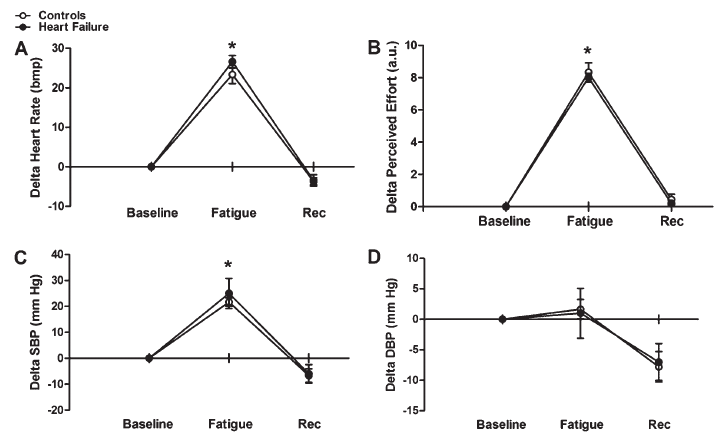
Figure 1. Changes in heart rate ( A ), perceived effort ( B ), systolic blood pressure (SBP) ( C ), and diastolic blood pressure (DBP) ( D ) during the respiratory fatigue protocol in patients with heart failure and in healthy controls. Data are reported as means±SD. Fatigue: average of the last 3 s before fatigue occurred; REC: recovery. *P , 0.05 fatigue vs baseline (two-way ANOVA followed by the Bonferroni post hoc test).